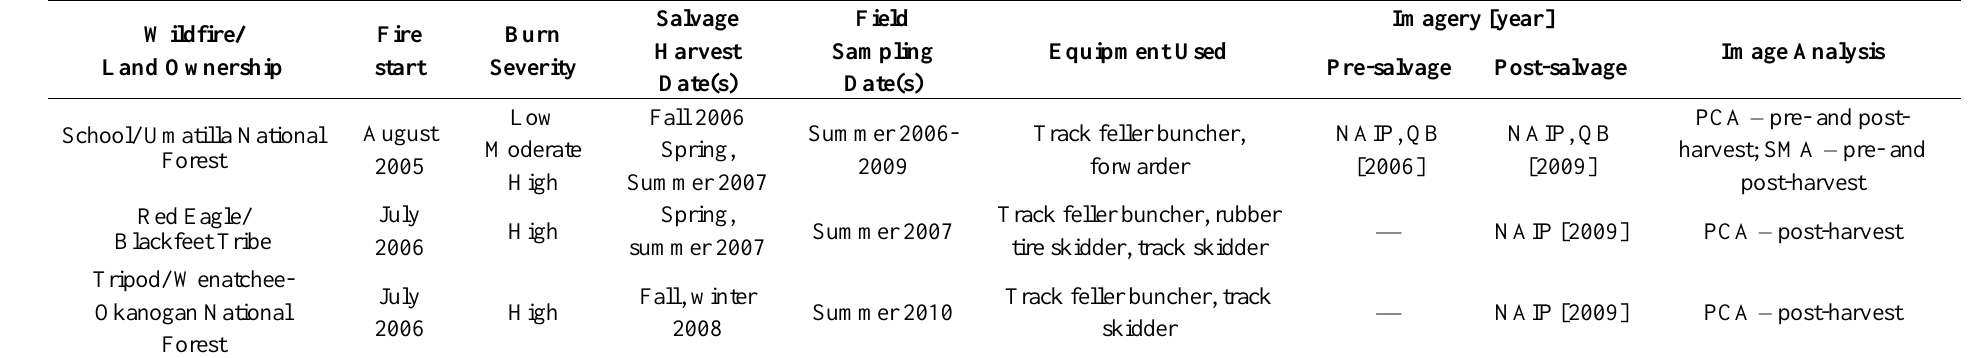
Table 2. Salvage harvest date and method, field, and remote sampling information by wildfire.